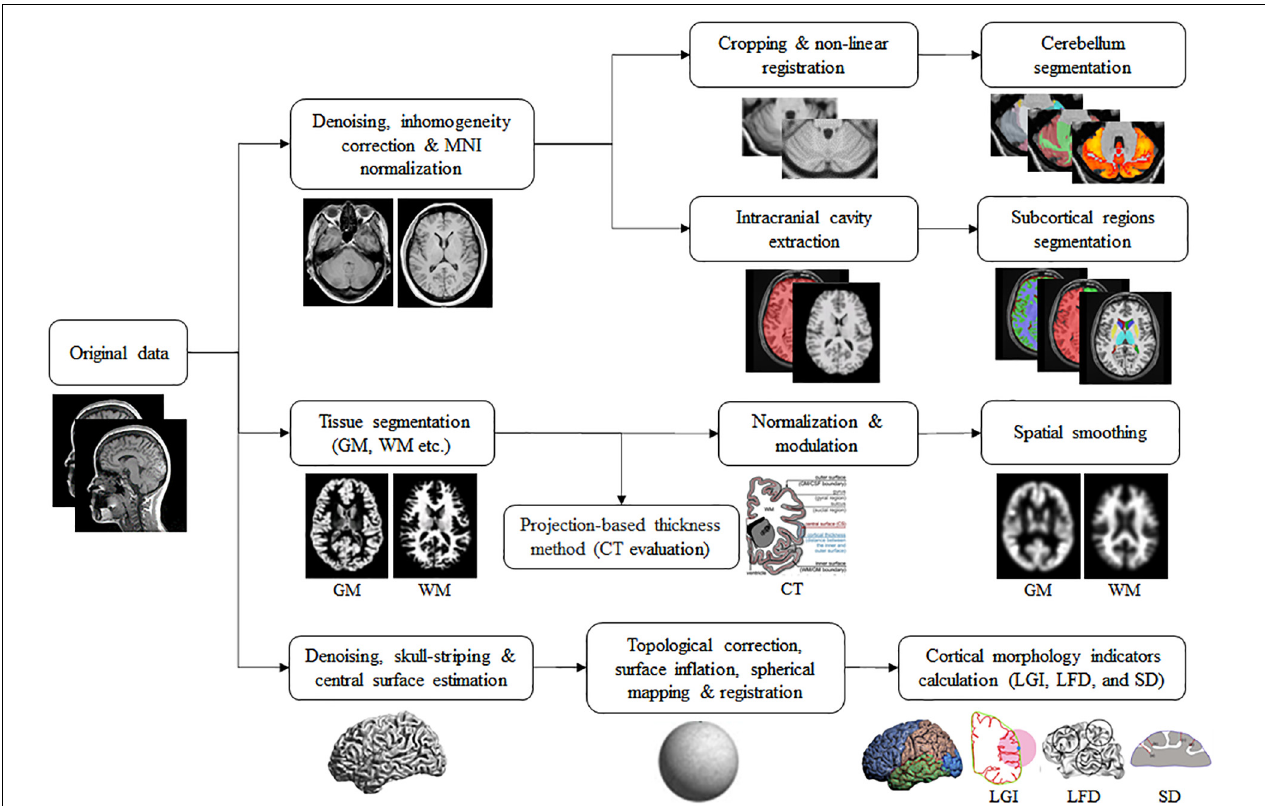
FIGURE 1 | The flowchart of data processing and extraction